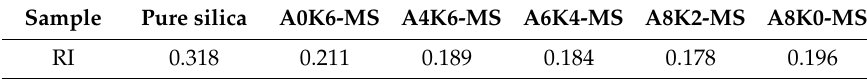
Table 3. Relative intensity (RI) of the peak at 3400 cm − 1 for pure silica and all modified silica. Sample